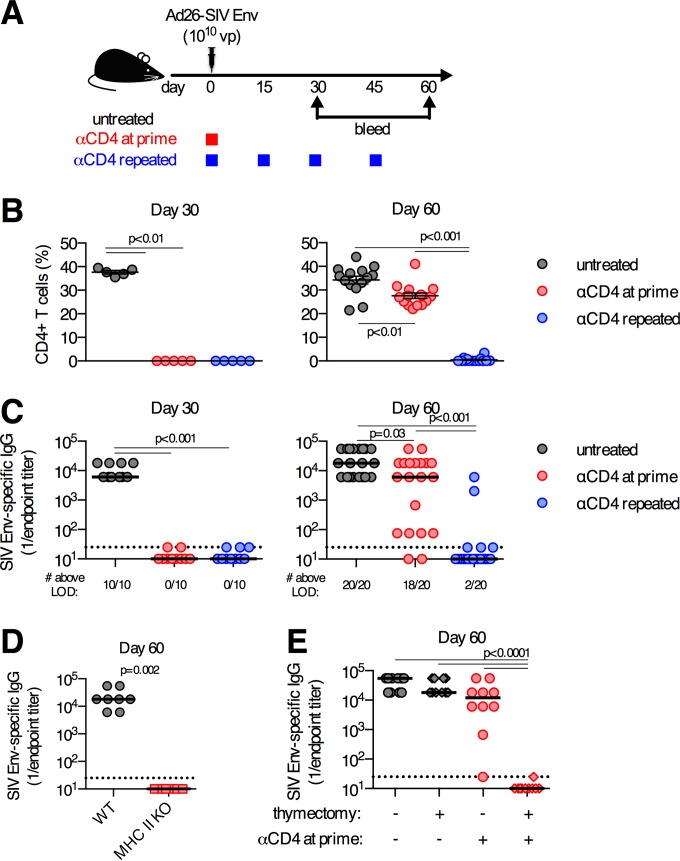
Repeated depletion of CD4+ T cells prevents development of delayed antibody responses. (A) C57BL/6 mice were depleted of CD4+ T cells a single time (anti-CD4 at prime), depleted of CD4+ T cells repeatedly (anti-CD4 repeated), or left untreated and immunized intramuscularly with 1010 vp of Ad26-SIV Env. (B) Frequency of CD4 T cells in iliac (draining) LNs. (C) SIV Env-specific serum-binding antibody titers. (D) Serum SIV Env-specific antibody titers on day 60 postimmunization from wild-type or MHC-II KO mice immunized with 1010 vp of Ad26-SIV Env. (E) Serum SIV Env-specific antibody titers on day 60 postimmunization from mice that underwent adult thymectomy, or not, and were treated with anti-CD4 antibody, or not, as indicated. Each dot represents an individual mouse, and the line indicates the mean ± the standard error of the mean (B) or median (C to E). The horizontal dotted line denotes the limit of detection (LOD) for the assay (for panel B, n = 5/group from one experiment [day 30] or n = 20/group pooled from four experiments [day 60]; for panel C, n = 10/group pooled from two experiments [day 30] or n = 20/group pooled from four experiments [day 60]; for panel D, n = 8/group pooled from two experiments; for panel E, n = 10/group pooled from two experiments).